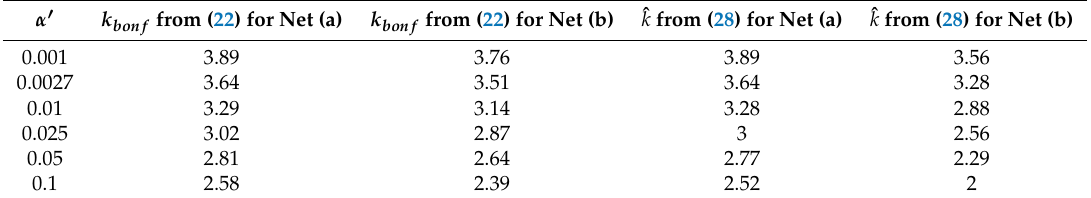
Table 4. Critical values from the Bonferroni and Monte Carlo procedures for networks ( a ) and ( b